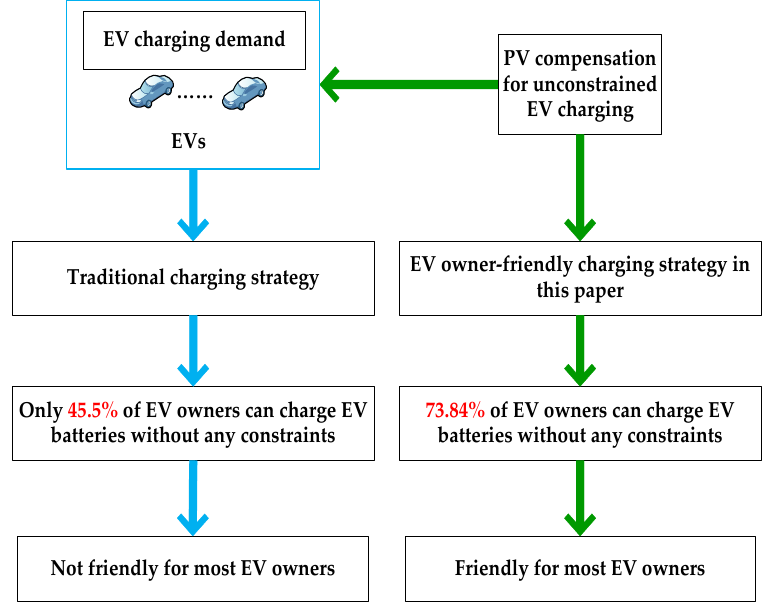
Figure 13. Analyses of the EV owner-friendly charging strategy.